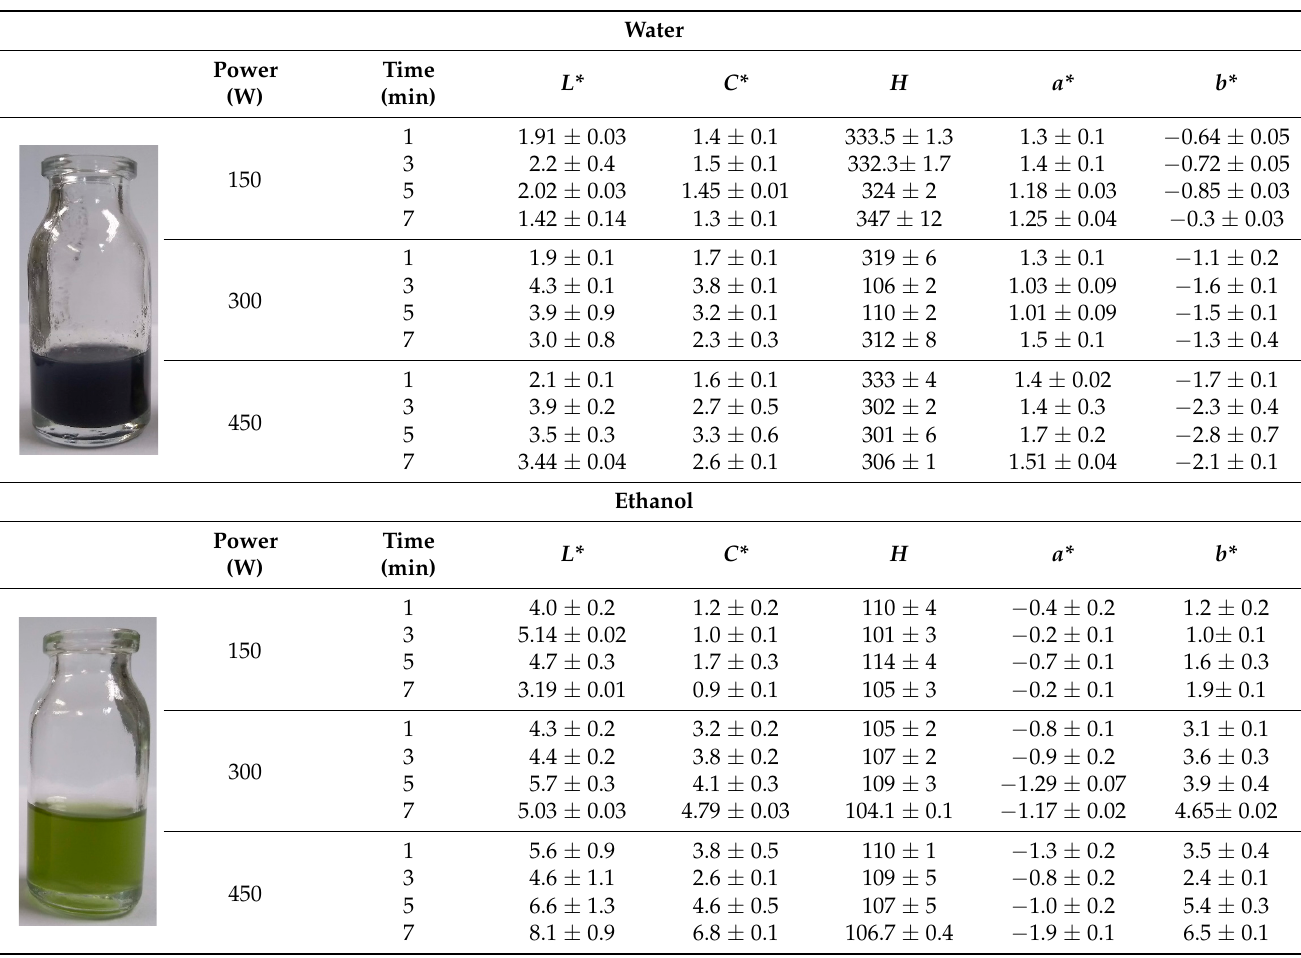
Table 2. Color parameters for the SDG extracts. Water